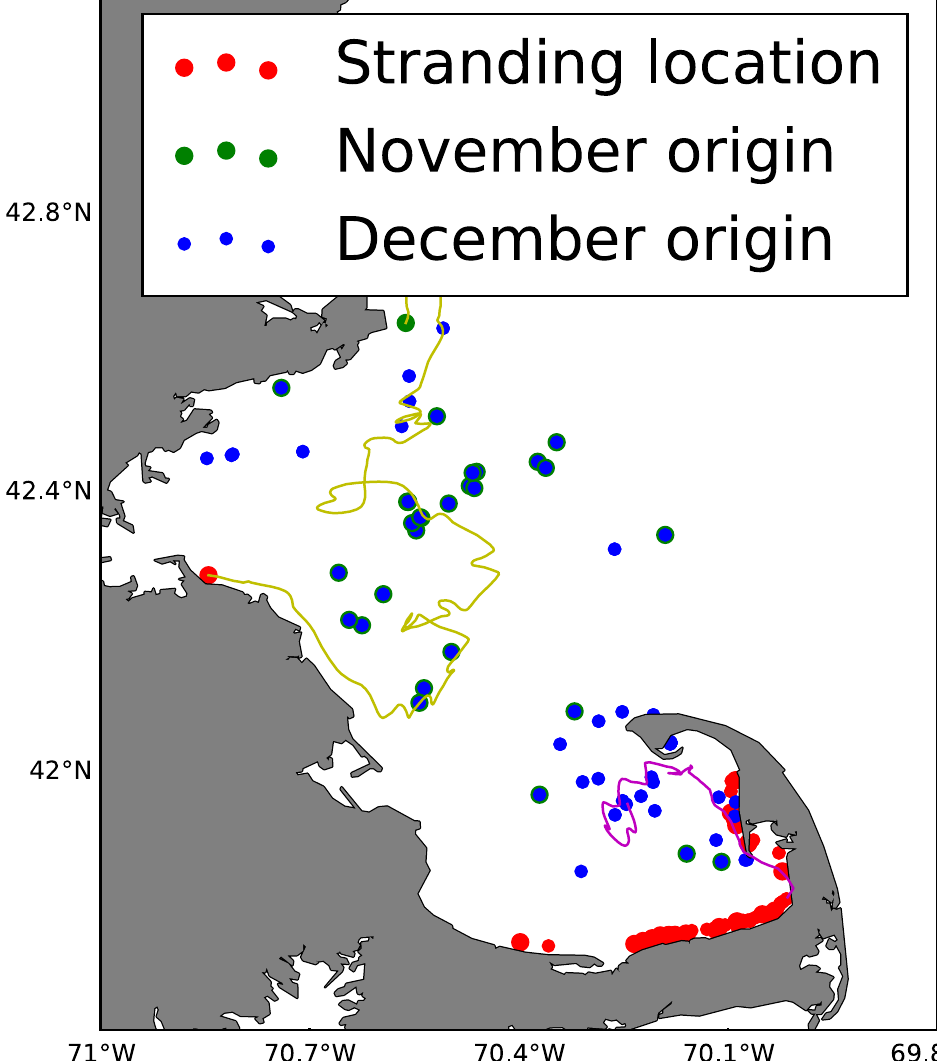
Fig 12. Backtracked positions of stranded sea turtles in 2012 and 2013. Red dots show the landing locations in November and December. Blue and green dots show estimated locations of backtracked turtles that stranded in November and December, respectively, when they first encountered < 10.5˚C water. These estimates assume that passive (non-swimming) turtles were only transported by currents when the modeled surface temperature was less than 10.5˚C. The yellow and magenta lines are examples of backtracking turtles that stranded in the western-most and eastern-most locations, respectively. According to the model, these turtles were first cold-stunned off Gloucester, MA and mid-Cape Cod Bay, respectively.